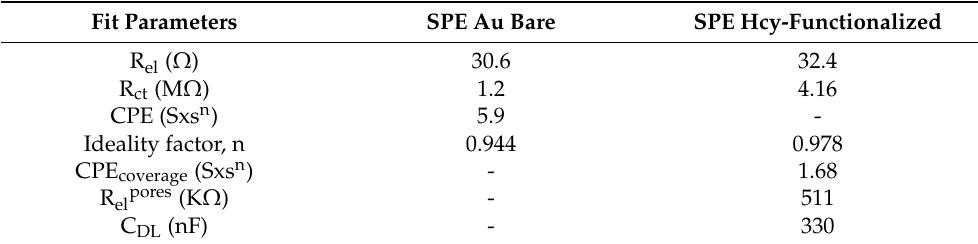
Table 1. Fit parameters extracted from EIS equivalent circuit model analysis. Fit Parameters SPE Au